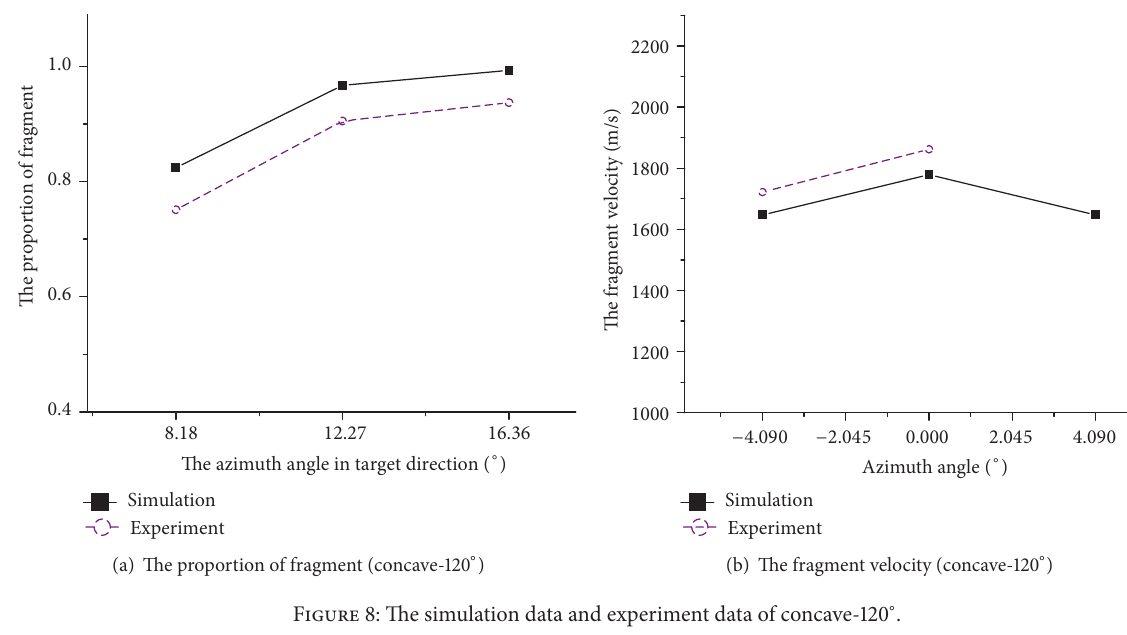
Figure 8: The simulation data and experiment data of concave-120 ∘ .